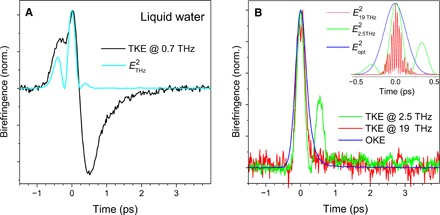
Impact of THz pump frequency on TKE signal of liquid water.(A) Bipolar TKE signal of water after pumping at 0.7 THz. The square of the THz field is given by the cyan line. (B) The TKE signals of water pumped at ~3 and ~19 THz and its OKE signal all have unipolar shape. All the signals are obtained at room temperature, where a 100-μm-thick liquid water film is held between a rear glass window and a 150-nm-thick SiN membrane as the entrance window.